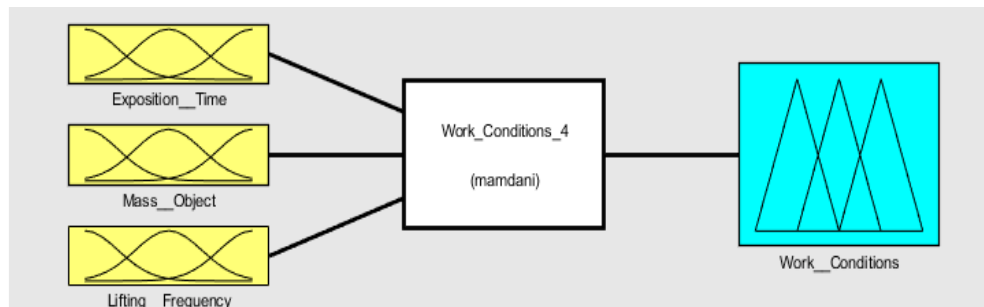
Figure 3. Default Mamdani-type inference display.